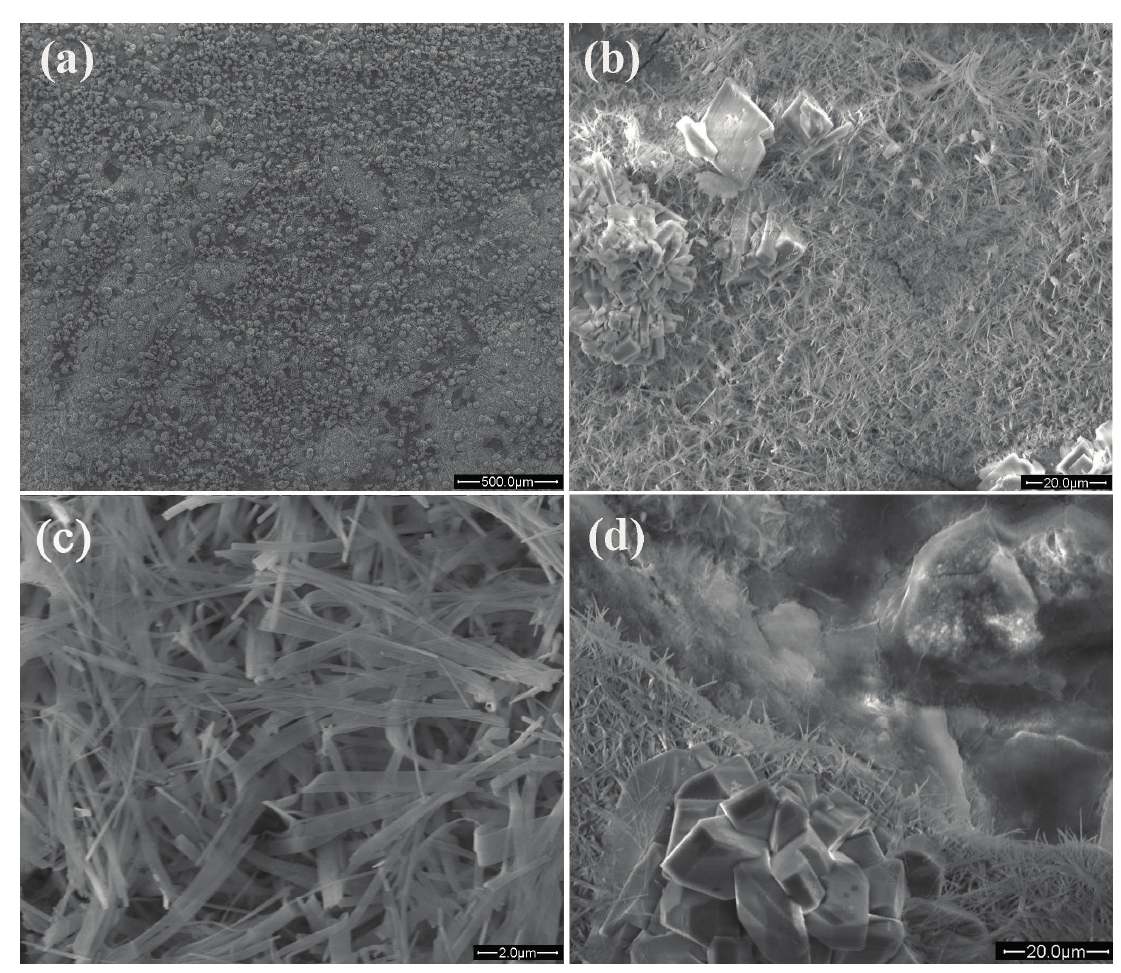
Figure 3. SEM images with different magnifications of nHA coatings on ZK60 substrate. ( a ) Integral morphology of the HA coatings; ( b ) Middle magnification SEM image; ( c ) High magnification SEM image; and ( d ) Bilayer structure of